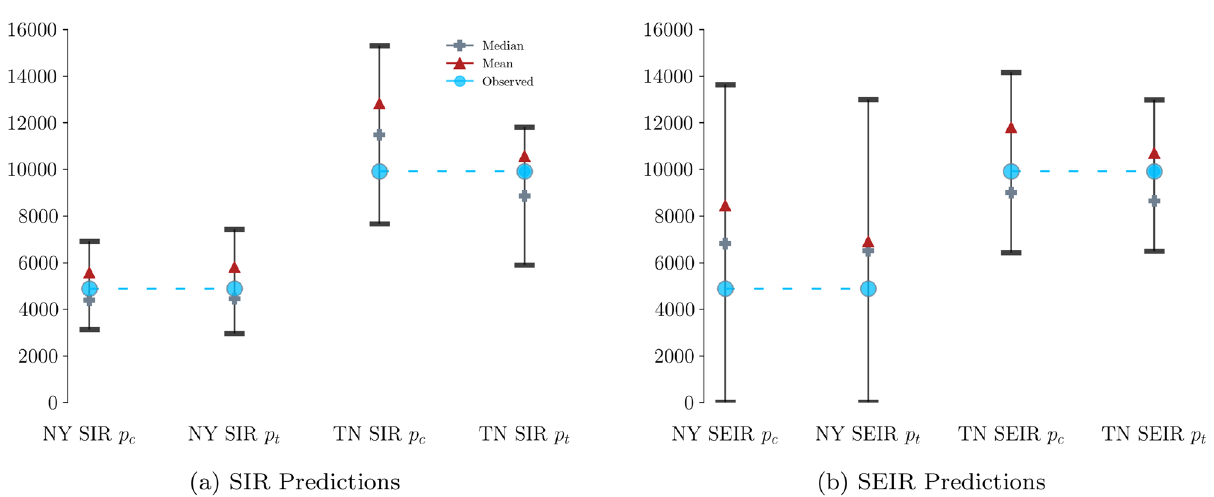
Figure 5. One-week ahead predictions of COVID-19 cases in New York (NY) and in Tennessee (TN) for the week starting August 31, 2020, using SIR and SEIR models with constant reporting rate ( p c ) or with time- varying reporting rate ( p t ). Red triangles and grey crosses denote posterior predictive means and posterior predictive medians, respectively. Bars represent 75% posterior predictive intervals. Blue circles depict the observed number of